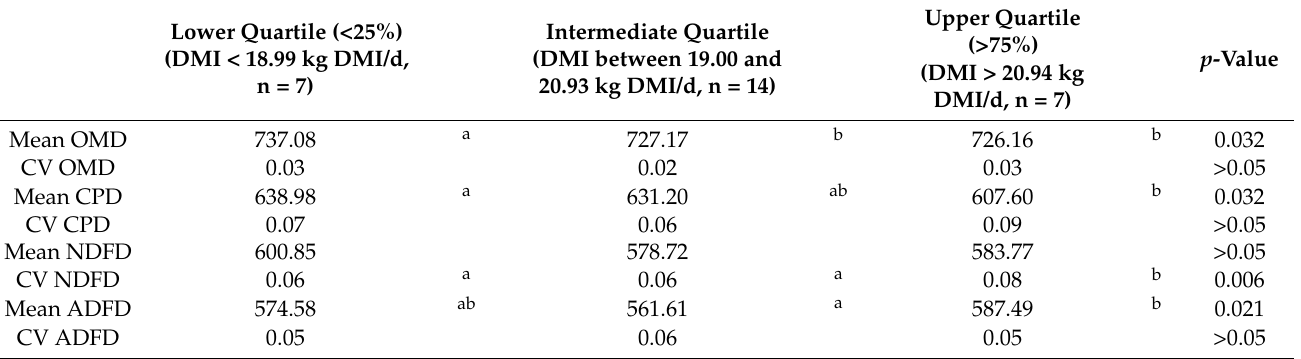
Table 7. Mean and CV values of nutrient digestibility of early lactating dairy cows grouped in quartiles according to mean DMI observed between week 2 and 15 of